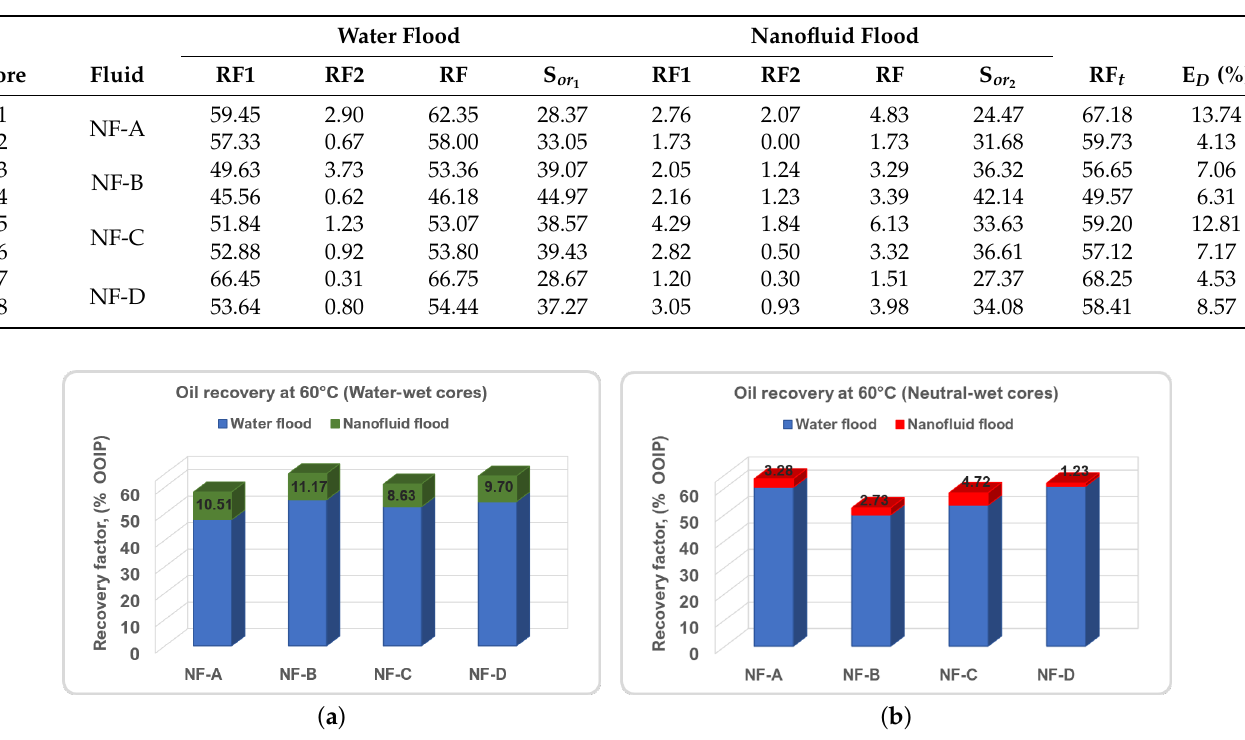
Table 5. Oil recovery factors (water- and nanofluid-flooding), expressed as % of the OOIP, and residual oil saturation achieved at the end of core flooding in neutral-wet cores.